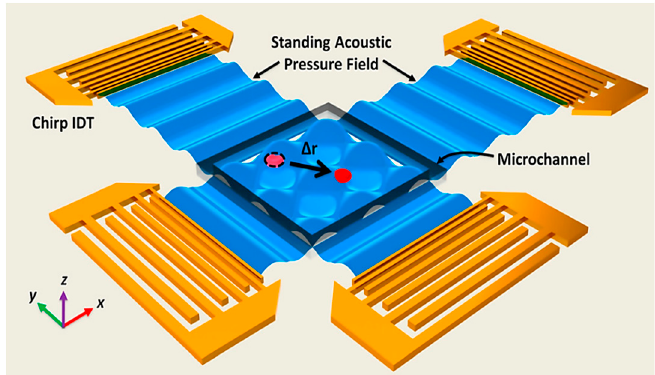
Figure 14. Schematic diagram showing the mechanism of the device proposed by Ding et al. Permission to reprint obtained from PNAS [95].